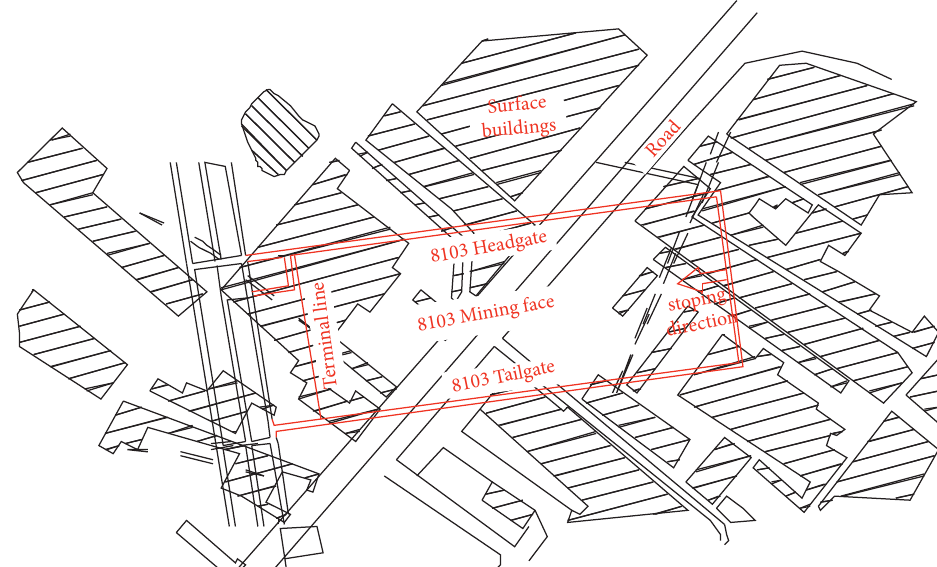
Figure 1: Layout of roadway in 8103 backfilling mining face and comparison between upper and lower wells.